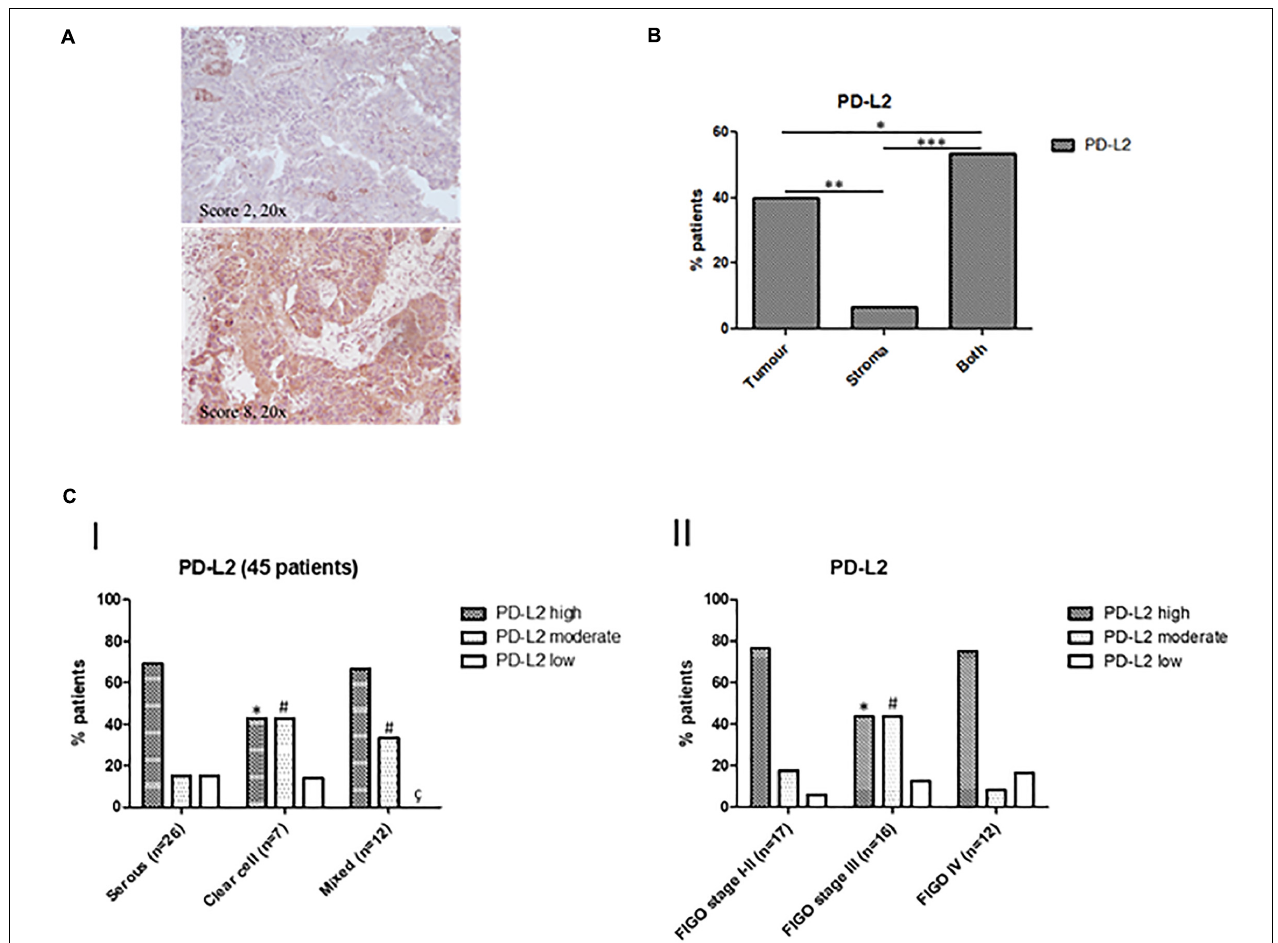
FIGURE 3 | (A) Representative images of IHC stainings for PD-L2 in human EC biopsies. Stainings and scores of representative tumors. Pictures were taken at × 20 magnification (scale bar, 50 µ m). (B) Percentages of patients classified according to PD-L2 distribution inside tumoral mass. (C) Classification of patients according to PD-L2 expression and clinicopathological characteristics. (I) Percentages of patients classified according to PD-L2 expression in EC, * p < 0.05 vs serous type PD-L2 high , # p < 0.05 vs serous type PD-L2 moderate , ç p < 0.05 vs serous type PD-L2 low . (II) Percentage of patients classified according to PD-L2 expression and FIGO stage, * p < 0.05 vs FIGO stages I–II PD-L2 high , # p < 0.05 vs FIGO stages I–II PD-L2 moderate